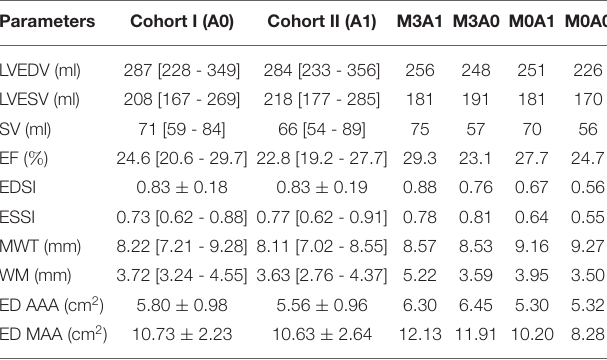
TABLE 2 | Geometric parameters of the two investigated cohorts and the four representative cases.